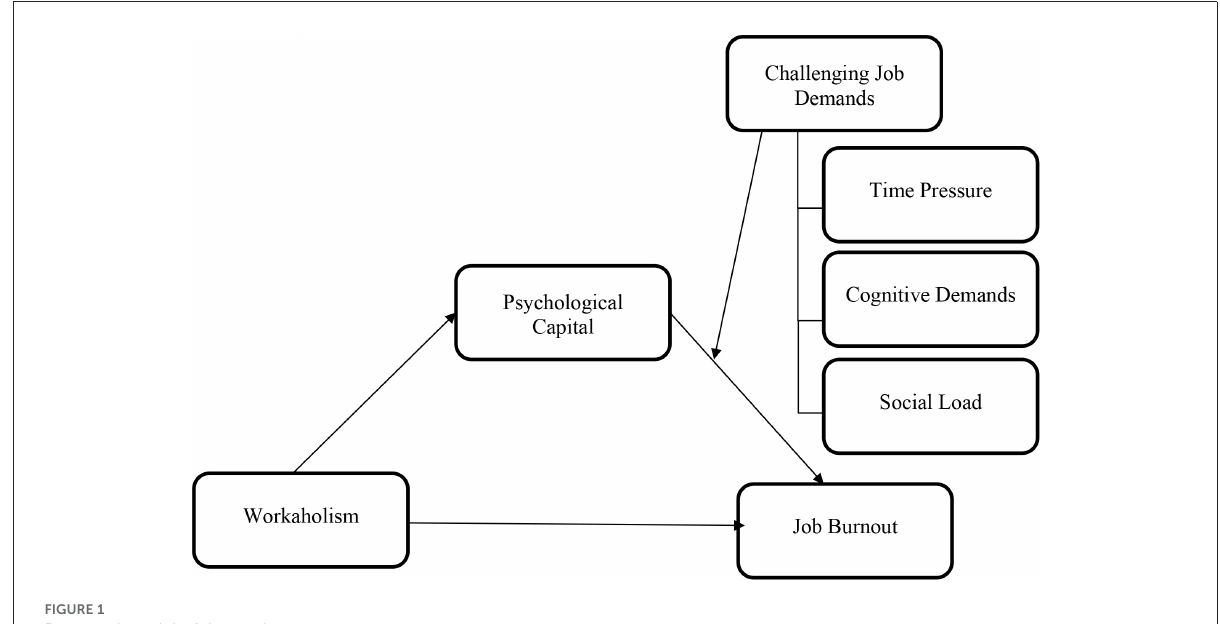
FIGURE1 Proposed model of the